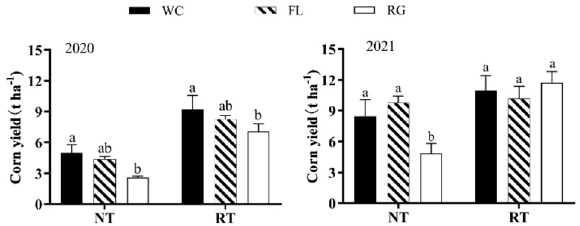
Figure 2. Corn yield over two years under different cover crops and tillage systems. NT, no − tillage; RT, rotary tillage. Different letters at the top of the bar chart denote significant differences among different treatments of cover crops for the same tillage at p < 0.05 by LSD test. The bar represents mean values of 4 replicates ± SD.